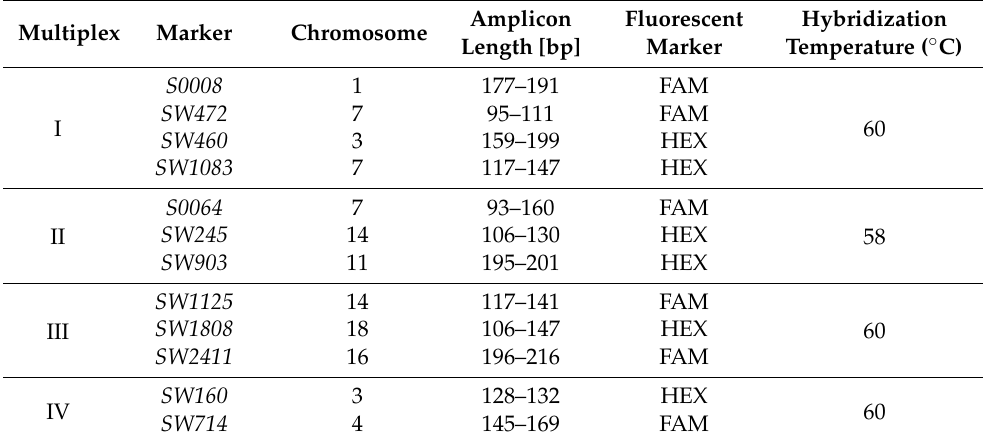
Table 2. Characteristics of microsatellite markers divided into individual multiplexes, the type of marker used, and the temperature of primer